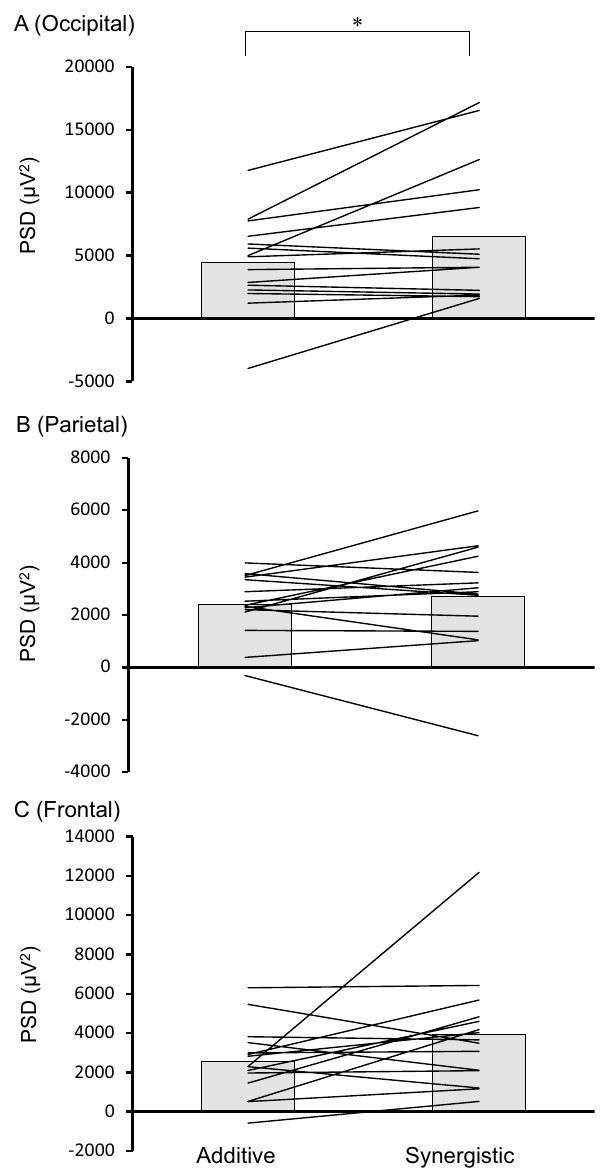
Figure 4. An index of additive and synergistic effects for alpha activity in occipital (A) , parietal (B) and frontal (C) site. The bars indicate means (N = 15). The solid lines indicate individual data (N = 15). * p < 0.05. PSD power spectrum